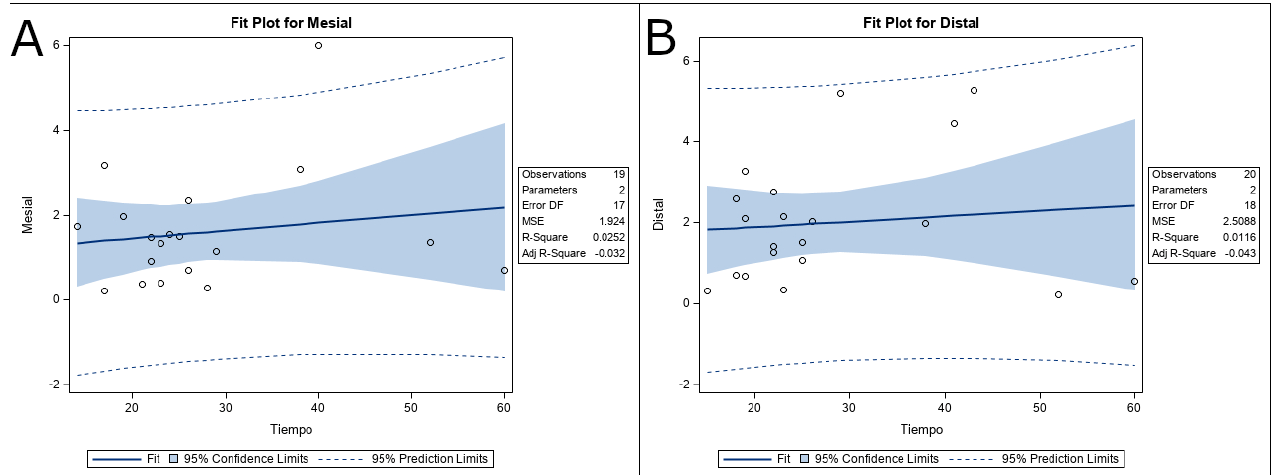
Figure 6. ( A ) Box plot of volume of dentin removed preoperatively and postoperatively, comparing the US and ER study groups at the apical level in the mesiobuccal and ( B ) distal root canal systems.